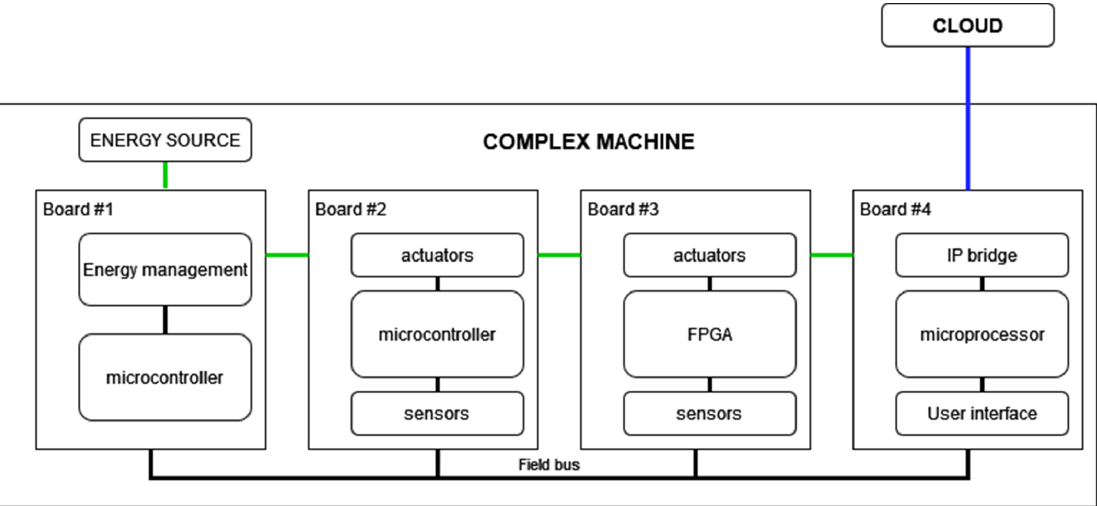
Figure 3. Block diagram of an example of a complex machine, green lines indicate energy flow, and blue lines indicate the data transmission to the cloud.